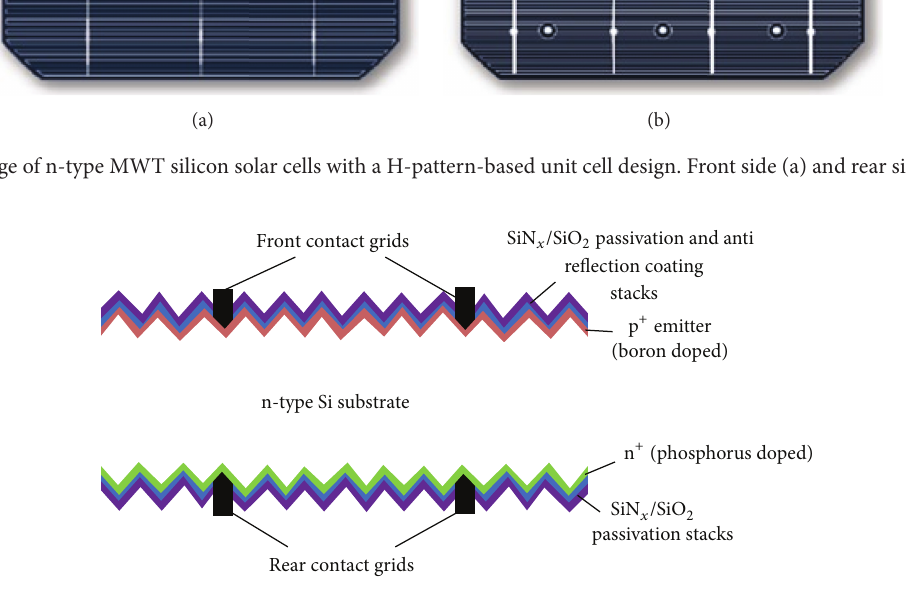
Figure 6: Structure of boron front emitter (p + nn + ) type cell. Such solar cell was fabricated by research team at Sunvia solar, where an ion- implantation technique was used for implanting the boron-doped emitter and phosphorus-doped BSF